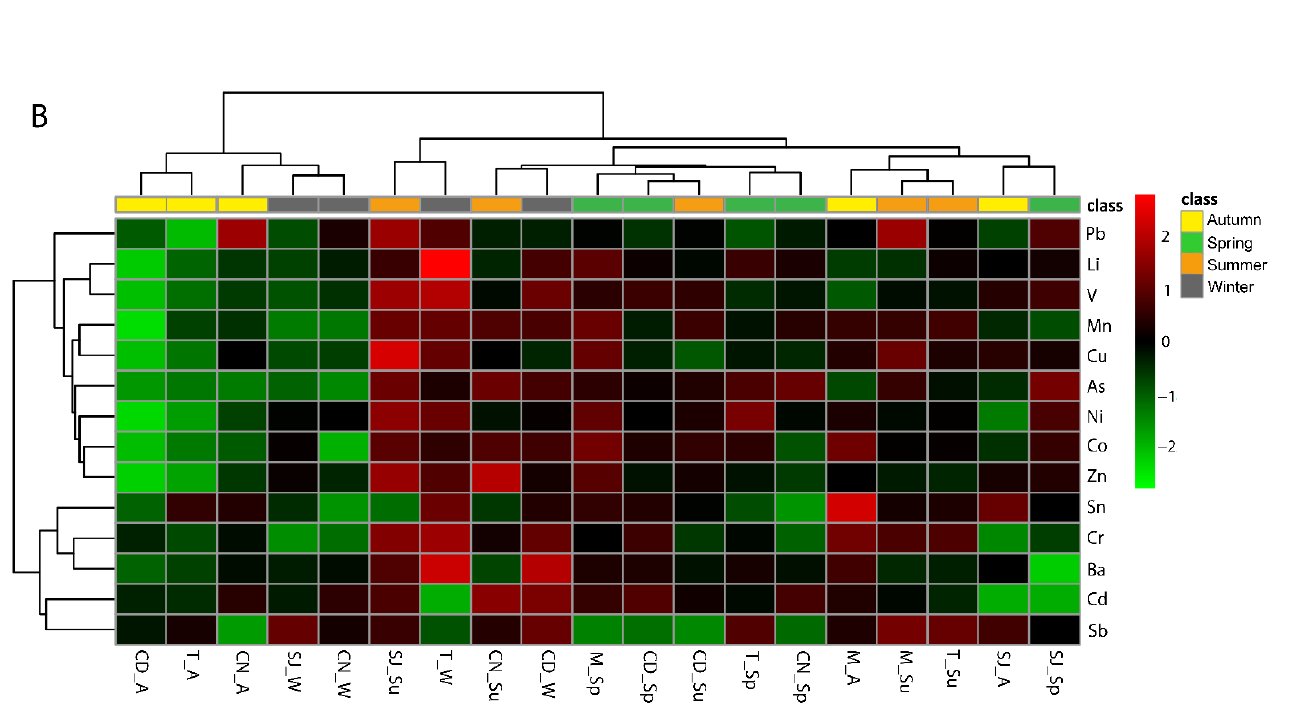
Figure 3. Heatmap with the biota–sediment accumulation factor (BSAF): ( A ) major BSAF (Al, Ca, Fe, K, Mg, Na, and P) and ( B ) trace element BSAF (As, Ba, Cd, Co, Cr, Cu, Li, Mn, Ni, Pb, Sb, Sn, V, and Zn) in Diopatra neapolitana tissues and sediments of the sampling sites. CD, M, SJ, T, and CN represent the sites Cale do Ouro, Murtosa, São Jacinto, Torreira, and Costa Nova, respectively. A, W, Sp, and Su represent the seasons of the year: autumn, winter, spring, and summer. The clusters in the figures allow the most similar responses to be grouped together.